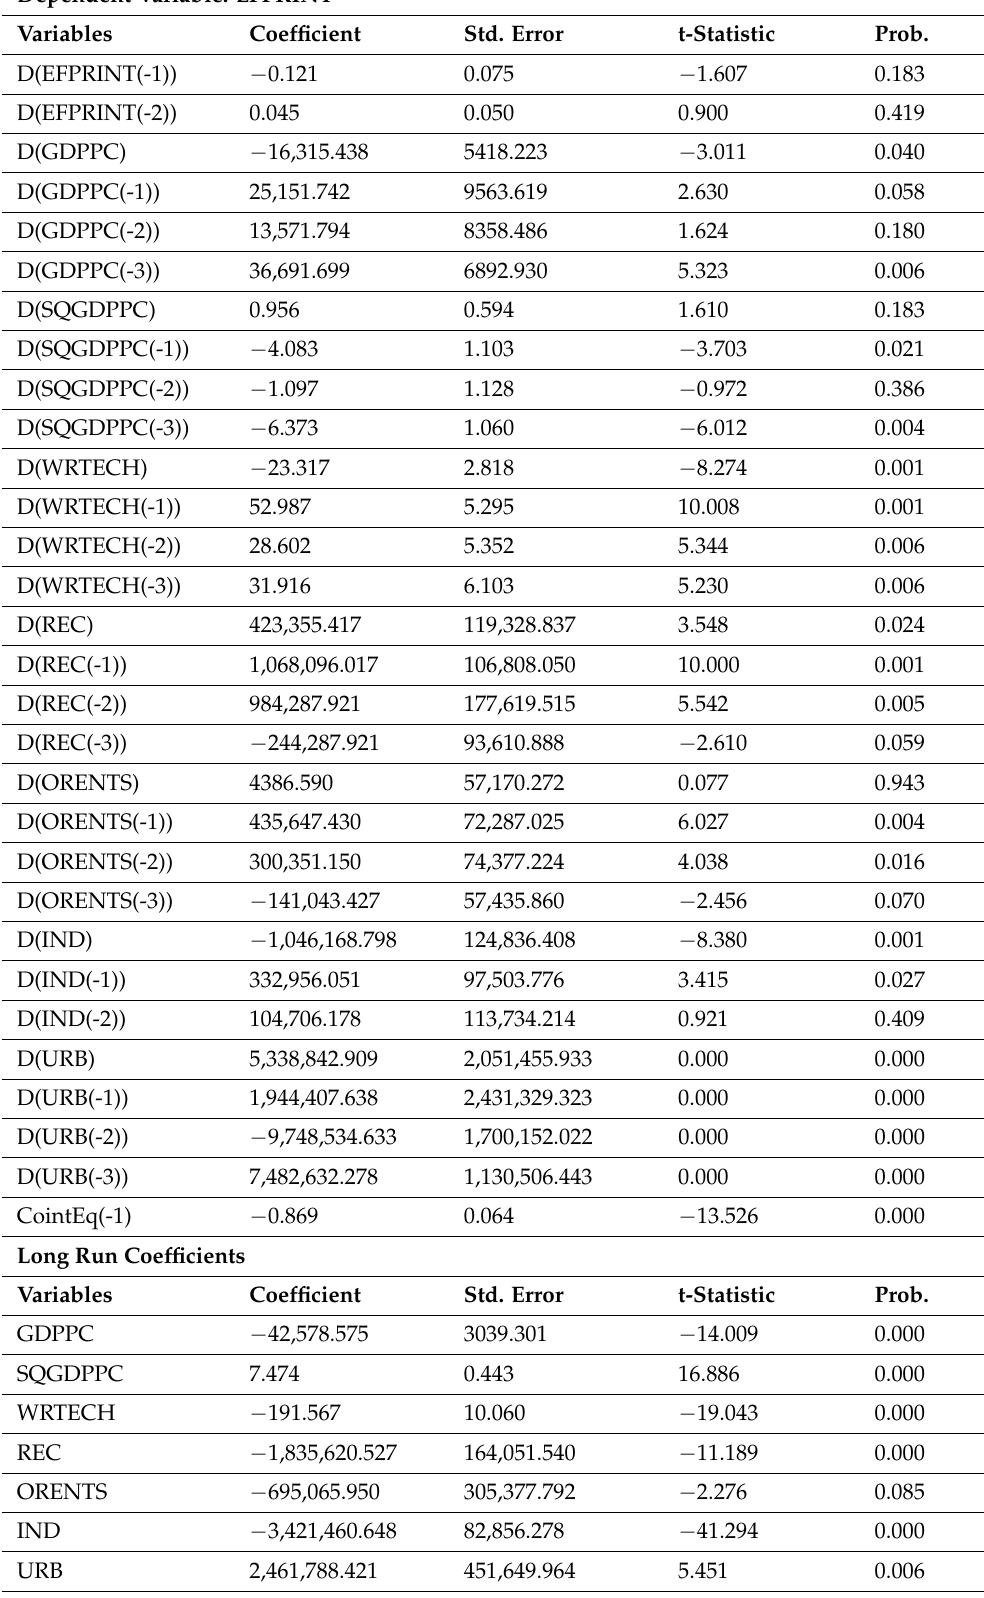
Table 7. ARDL short- and long-term